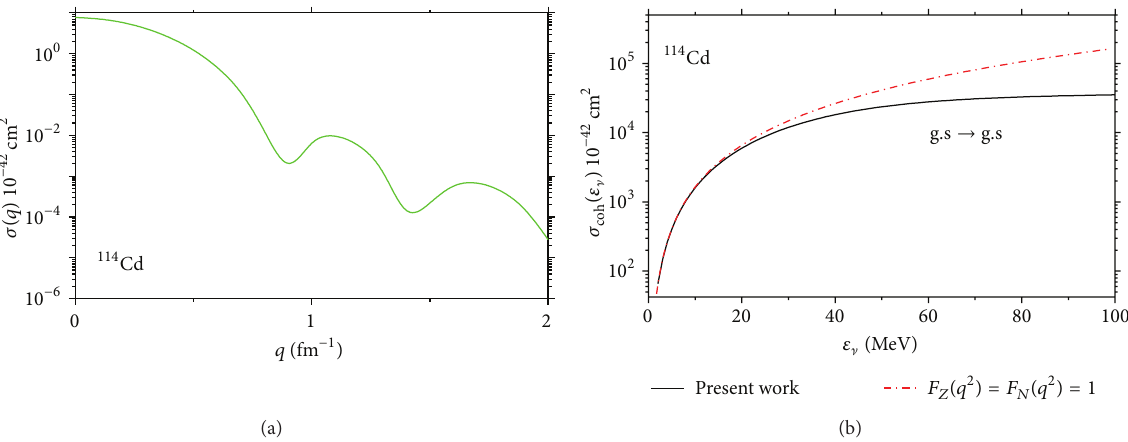
Figure 2: Coherent total cross section for the neutral current reactions 114 Cd ( ] 𝑙 , ] 󸀠 𝑙 ) 114 Cd ∗ , 𝑙 = 𝑒, 𝜇, 𝜏 : (a) as a function of the momentum transfer 𝑞 and (b) as a function of the incoming neutrino energy 𝜀 ] . The dash dotted curve results by assuming zero momentum transfer; that is, 𝐹 𝑍 (𝑞 2 ) = 𝐹 𝑁 (𝑞 2 ) = F (𝑞 2 ) = 1 .